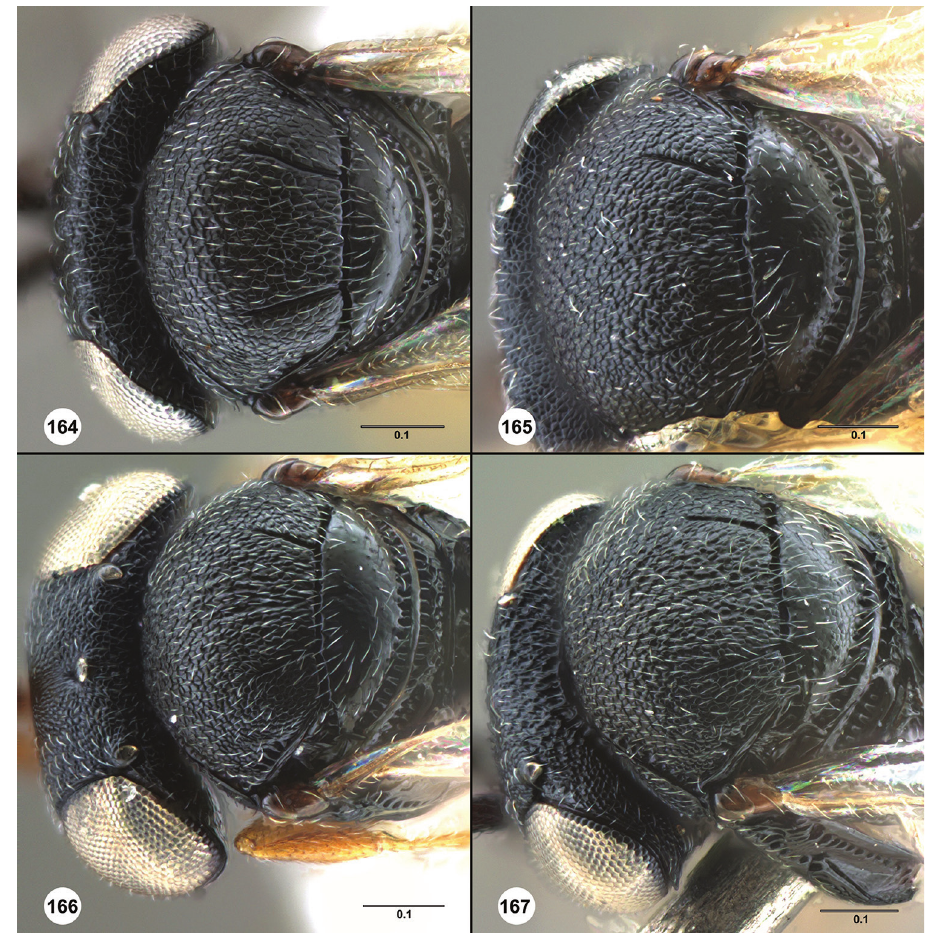
dorsal view 165 female (USNMENT00872172), head and mesosoma, dorsal view 166 female (USN- MENT00896206), head and mesosoma, dorsal view 167 female (USNMENT01059030), head and mesosoma, dorsal view. Scale bars in